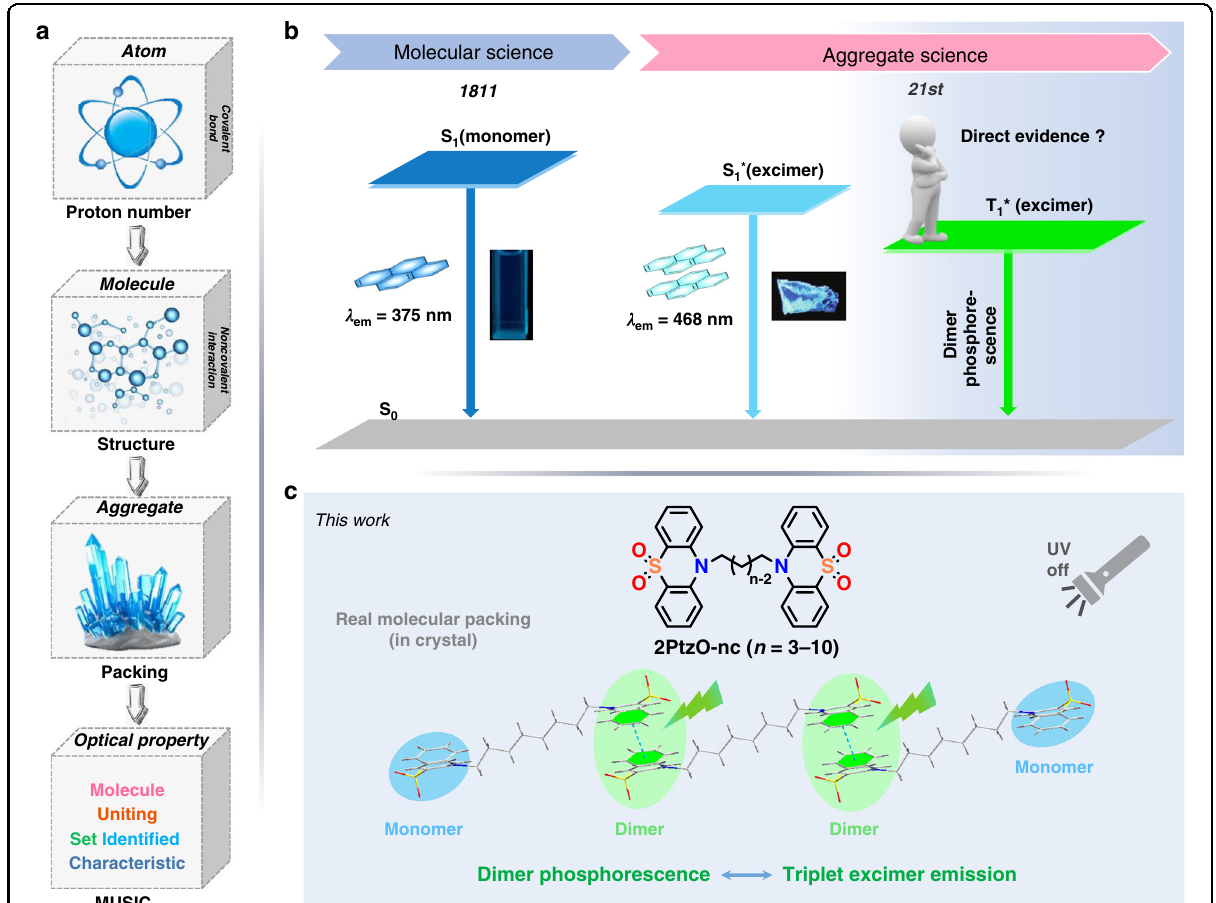
Fig. 1 Strategy for molecular design. a Critical factor affecting chemical properties: Atoms with different proton numbers form molecule through covalent bonds, while molecules with different or the same structure form molecular aggregates through non-covalent bonds, lead to the characteristic of Molecular Uniting Set Identi fi ed Characteristic (MUSIC). b Development process from “ molecular science ” to “ aggregate science ” . c Different room temperature phosphorescence (RTP) emissions from monomer and dimer based on different molecular packing of phenothiazine- 5,5-dioxide